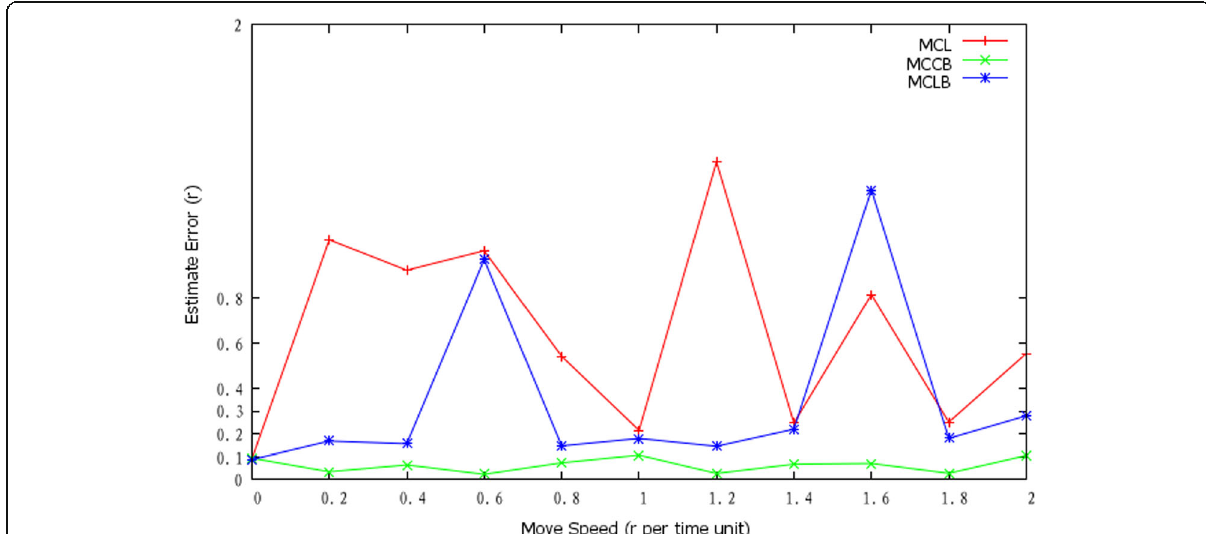
Fig. 6 Anchor node by 10-m interval comparison chart. From the top the anchor node, the spacing was 10 m in the comparison chart; when the node ’ s moving speed changes from 0 m to 100 m accuracy, in which CMCL positioning accuracy is the best; when the positioning accuracy is